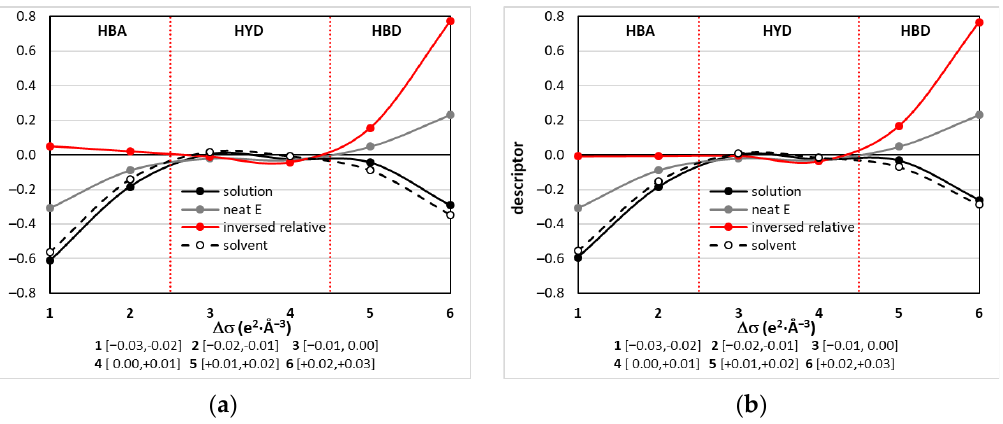
Figure 12. Illustration of σ -potential-related molecular descriptors characterizing systems with the highest edaravone solubility, which are ( a ) ETA and ( b ) GLE with x* DES = 0.6 at T = 298.15 K. The grey lines represent properties of neat edaravone while black solid and dashed lines characterise solute-free solutions and the mixture, respectively. Red line denoted as the inverse relative curve represents values between inversed plot of neat edaravone and solute-free solvent.